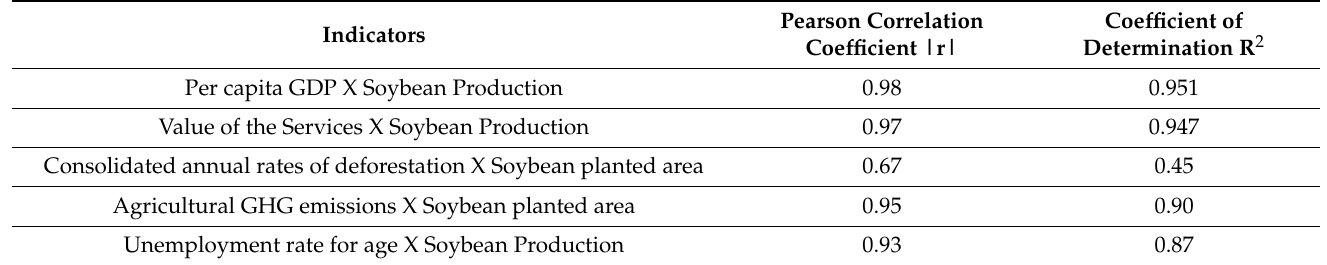
Table 14. Pearson correlation coefficient of Amazon